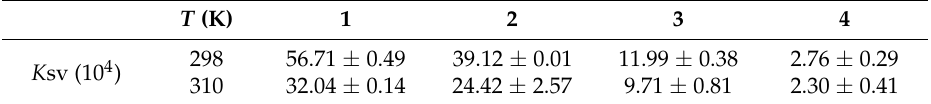
Table 2. Stern–Volmer quenching constant ( K sv , L · mol − 1 ) values for the complex-H33528